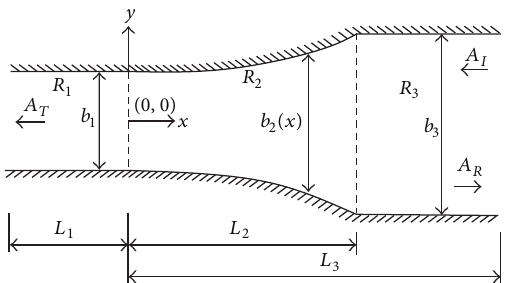
Figure 1: The top view diagram of the physical model studied. The water wave amplitude 𝐴 𝑤 for 𝑤 = 𝐼, 𝑅 , and 𝑇 represents the incident (travelling from right to the left hand side), reflected, and transmitted water waves, respectively. The harbor is formed for three regions 𝑅 1 , 𝑅 2 , and 𝑅 3 .